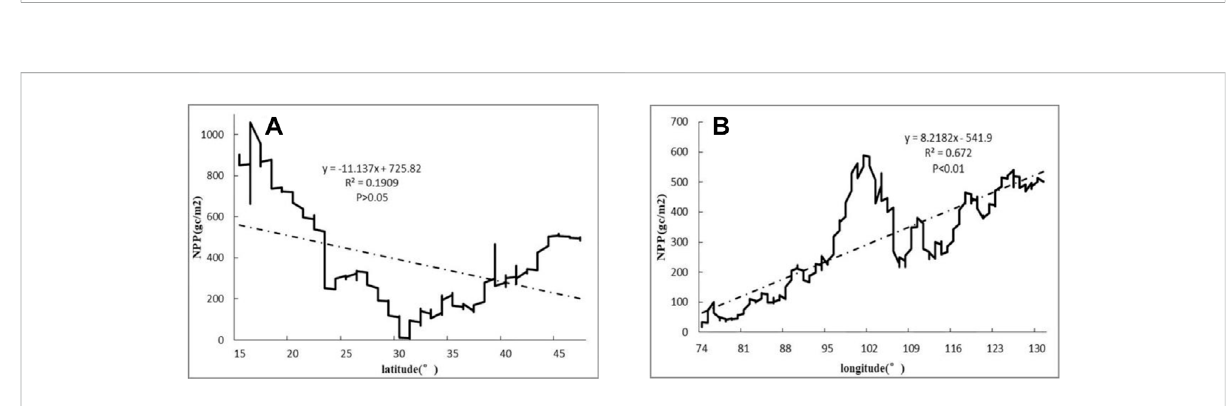
FIGURE 10 (A) Changes in the relationship between annual NPP and lattitude. (B) Changes in the relationship between annual NPP and